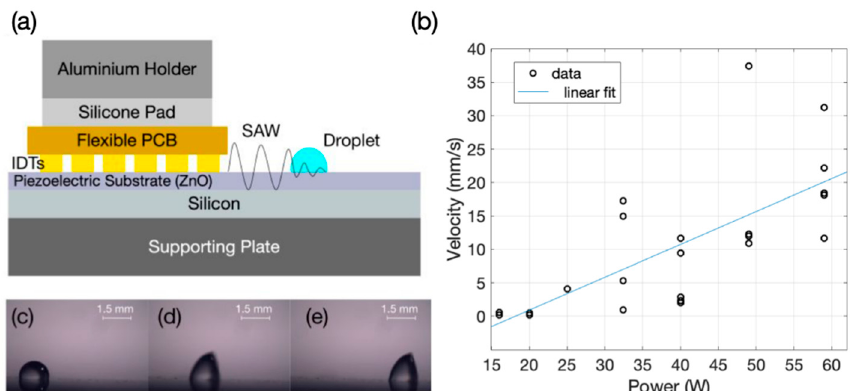
Figure 2. ( a ) An illustration of the experimental setup for microfluidics, ( b ) average pumping velocities achieved by different power levels applied to the electrode pads of the fabricated structure. ( c – e ) Snapshots taken of a video with a duration of 3 s at time intervals of 0.42, 0.54, 0.74 s respectively. In this experiment, a 2 μ L DI droplet was placed in front of the IDTs and power of 26.2 W was applied at 64 MHz to the electrode pads.